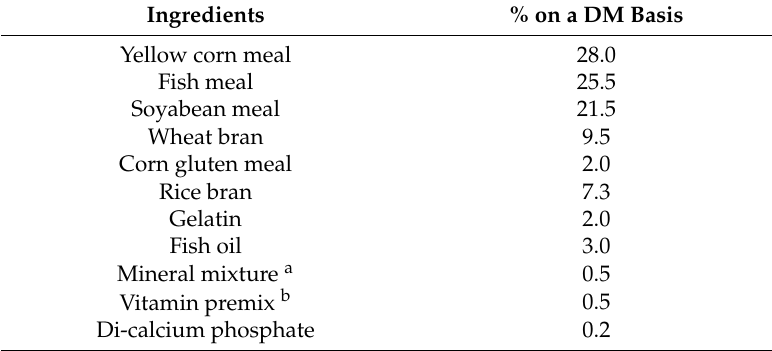
Table 1. The ingredients and proximate chemical analysis (%) based on the dry matter (DM) basis of the basal diet used in the current